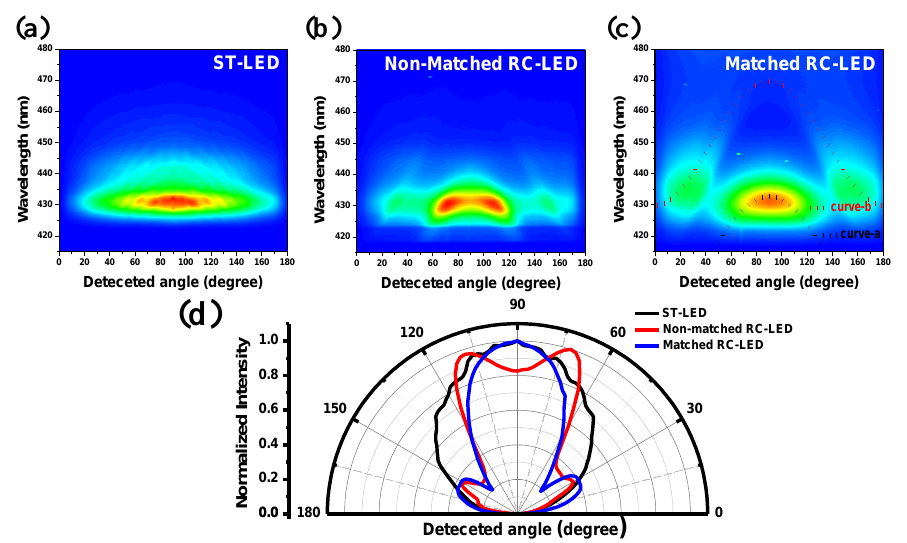
Figure 3. The photoluminescence (PL) emission spectra of ( a ) the ST-LED, ( b ) the non-matched RC-LED, and ( c ) the matched RC-LED were measured through the angle-resolved PL measurement. ( d ) Normalized far-field radiation patterns of all LED structures were measured.